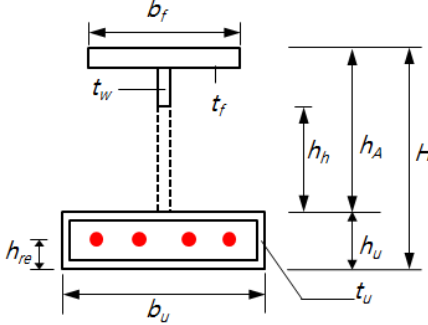
Figure 10. Cross-sectional shape of the non-composite beam with web openings.